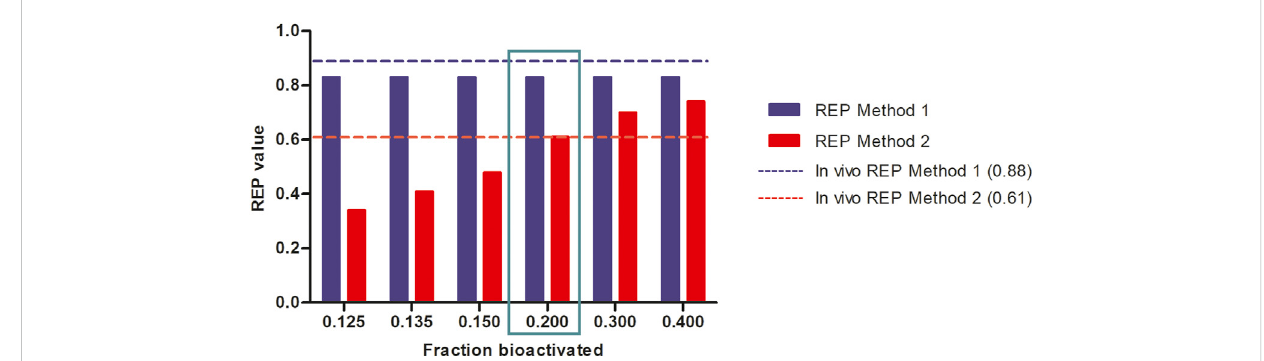
FIGURE 6 In fl uence of the assumed fraction bioactivated on REP values when calculated based on PBK modeling-based predictions at a dose level of 55 μ mol kg -1 bwofSENOandSENasusedbyYangetal.(Yangetal.,2017a)intheir invivo ratstudyassuming8.20%bioavailability,andusingan invitro k